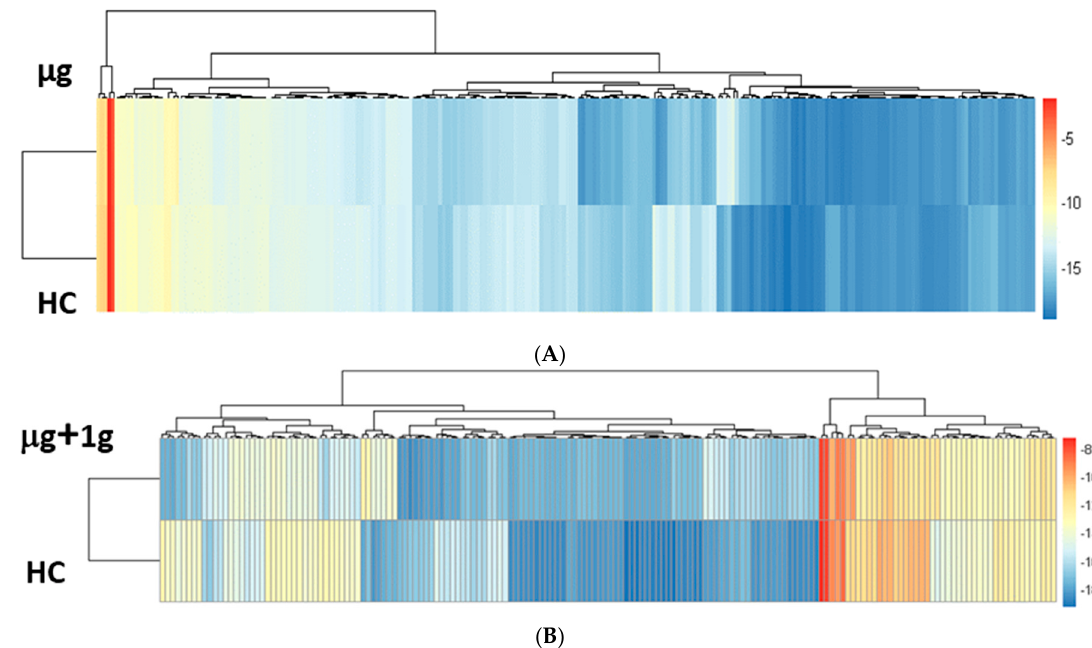
Figure 3. Unsupervised hierarchical clustering of significantly differentiating proteins. ( A ) Significant proteins between the µg versus habitat controls (HC). 250 Significant proteins based on false discovery rate (FDR) adjusted ( p < 0.05); ( B ) significant proteins between µg + 1 g versus HC. 171 Significant proteins based on FDR adjusted ( p < 0.05). Unsupervised hierarchical clustering of the log 2 normalized iBAQ intensities for significantly differentiating proteins was performed using the Euclidean distance metric with oheatmap R package. The hierarchical cluster was generated for comparison and visually represents the significant protein intensities for each sample group. The intensities were standardized by the mean and standard deviation before clustering. Proteins were considered significant based on Mann–Whitney U FDR corrected p -value < 0.05.